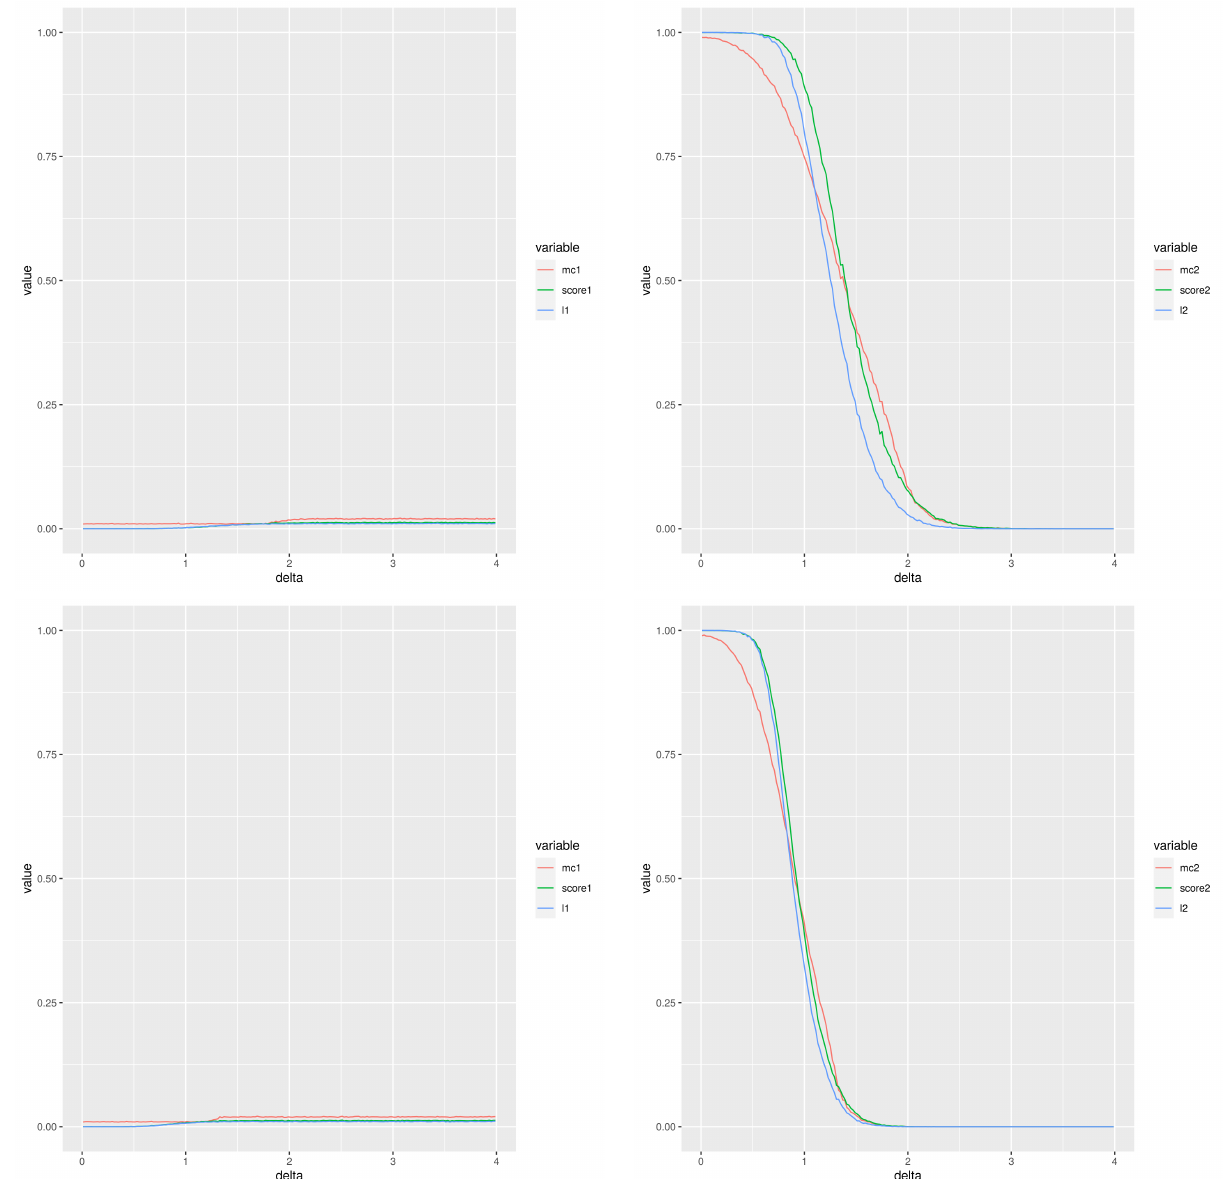
Figure 2. Type I ( left column) and type II ( right column) errors when comparing two groups of gamma distributed random values. The difference between the means is the abscisa, δ . Please, notice the different scales in the Y-axis for types I and II. First and third rows (respectively, second and fourth rows) correspond to two groups of 10 values (respectively, 20 values). The two first rows (respectively, the two last rows) use a false discovery rate equal to 0.001 (respectively,